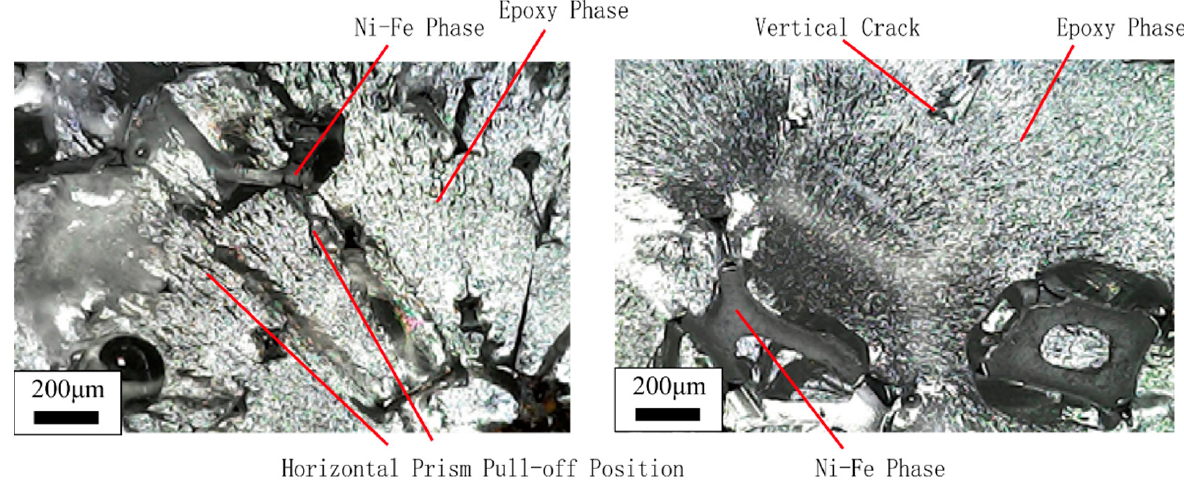
Figure 9. The micrograph of damage specimen in Ni-Fe/EP IPC fracture section.